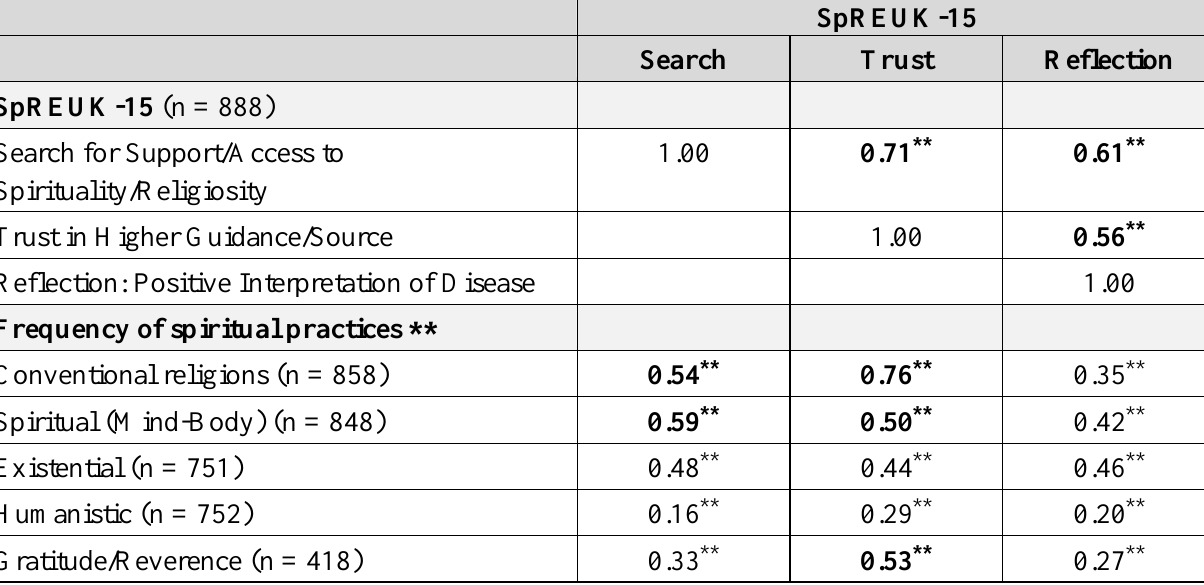
Table 2. Correlation between spiritual/religious attitudes and engagement frequency